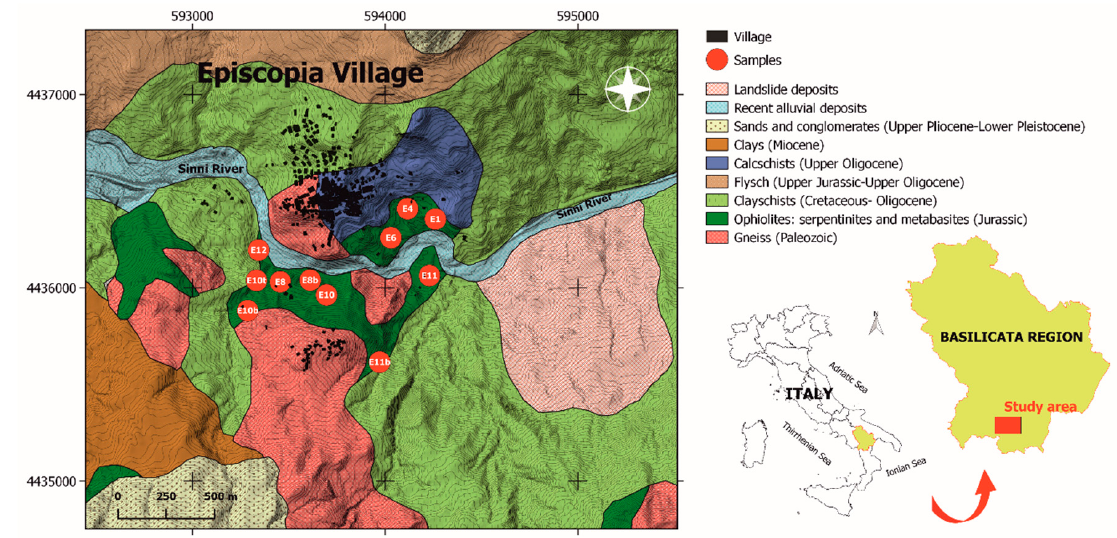
Figure 1. Simplified geological map of the Episcopia village and the study area location with the sample sites .